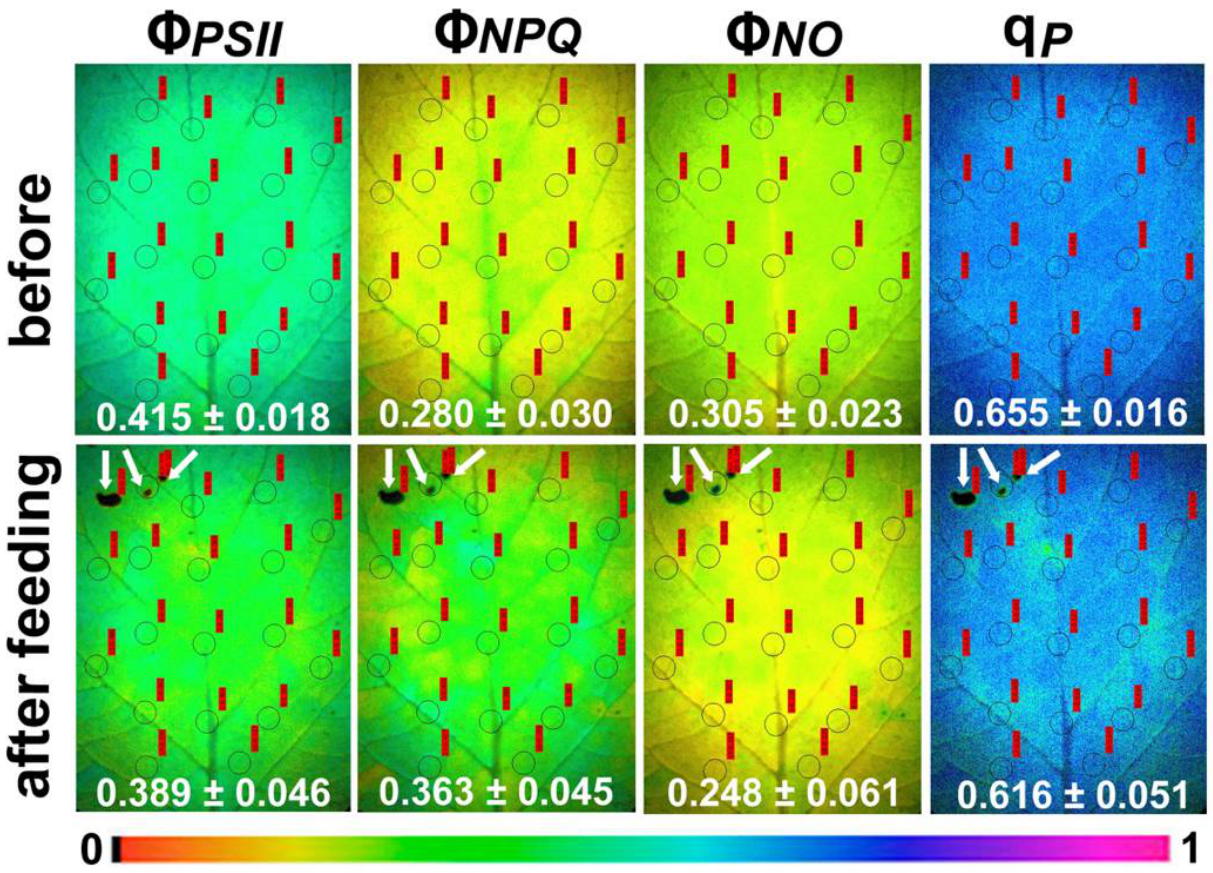
Figure 1. Representative images of the effective quantum yield of PSII photochemistry ( Φ PSII ), the quantum yield of regulated non-photochemical energy loss in PSII ( Φ NPQ ), the quantum yield of non-regulated energy loss in PSII ( Φ NO ), and the fraction of open PSII reaction centers (qp) of potato leaves before and after Tuta absoluta feeding. The areas of interest (AOIs) are shown in each image, with their values in red labels, together with the whole leaflet average value ( ± SD). The white arrows in the images show the feeding zones. The color code depicted at the bottom ranges from values 0 to 1.